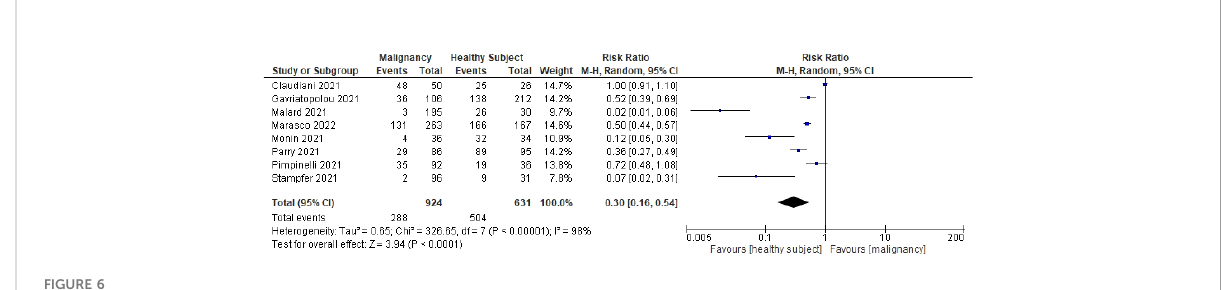
FIGURE 6 Sub-analysis of the seroconversion rate after receiving only the fi rst dose of